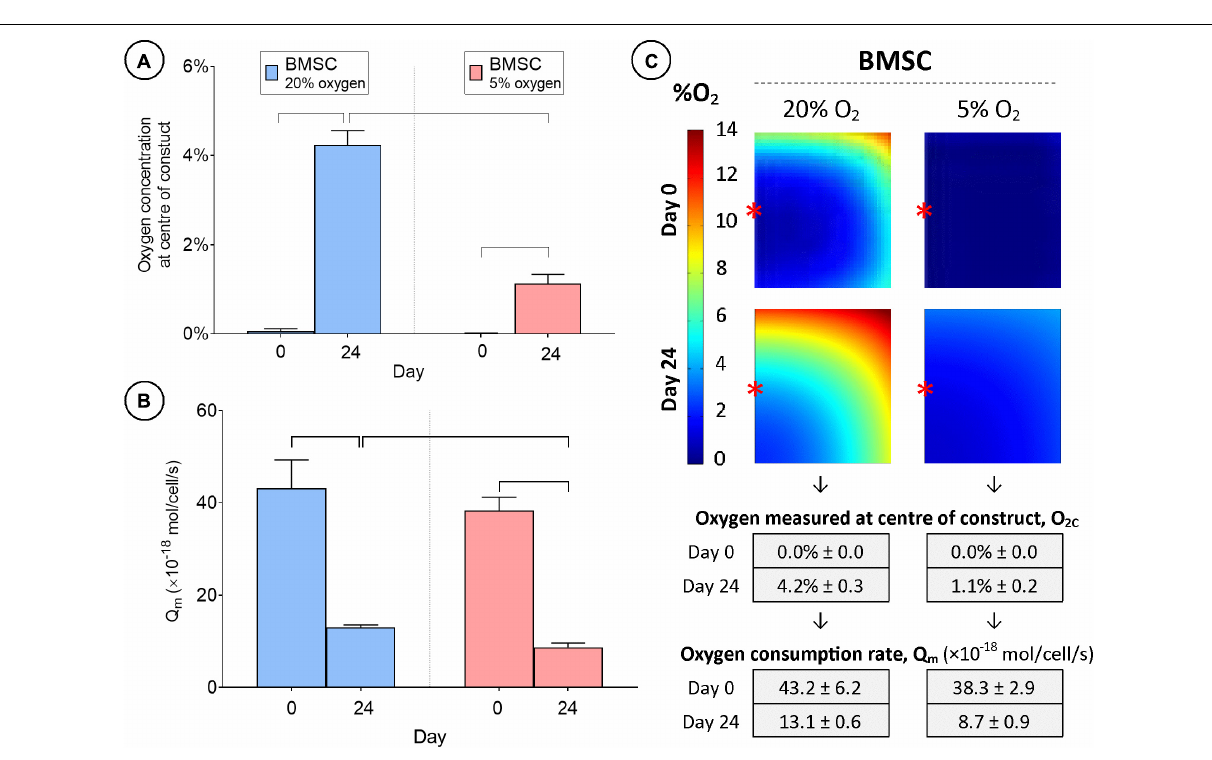
Frontiers in Bioengineering and Biotechnology |